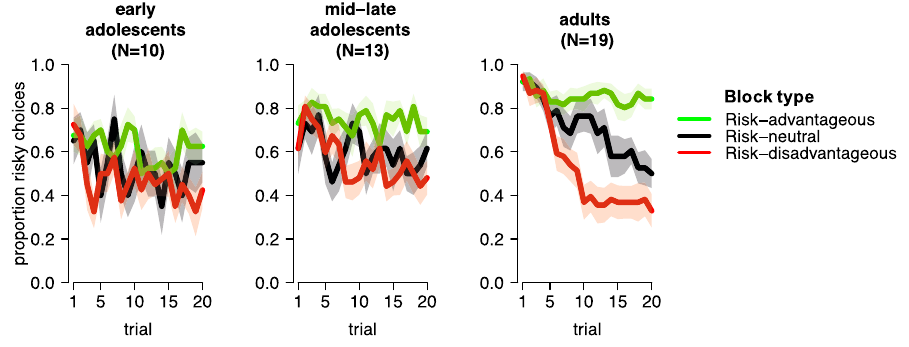
Figure 2. Mean proportion of choices for the risky option per trial, block type, and age group. Shaded areas represent 1 SEM. This figure was created using RStudio 1.1.463, https:// www. rstud io.